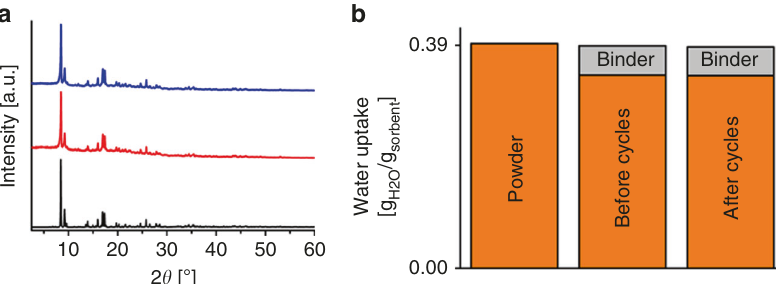
Fig. 4 Proof of integrity of coated CAU-23 before and after 5000 cycle stability measurement. a PXRD patterns of CAU-23 before (red) and after 5000 sorption cycles (blue). A calculated pattern (black) based on the crystal structure is also provided. b Gravimetric determination of the water uptake capacity of CAU-23 coatings before and after the 5000 cycle stability measurement in comparison with the value of the pure